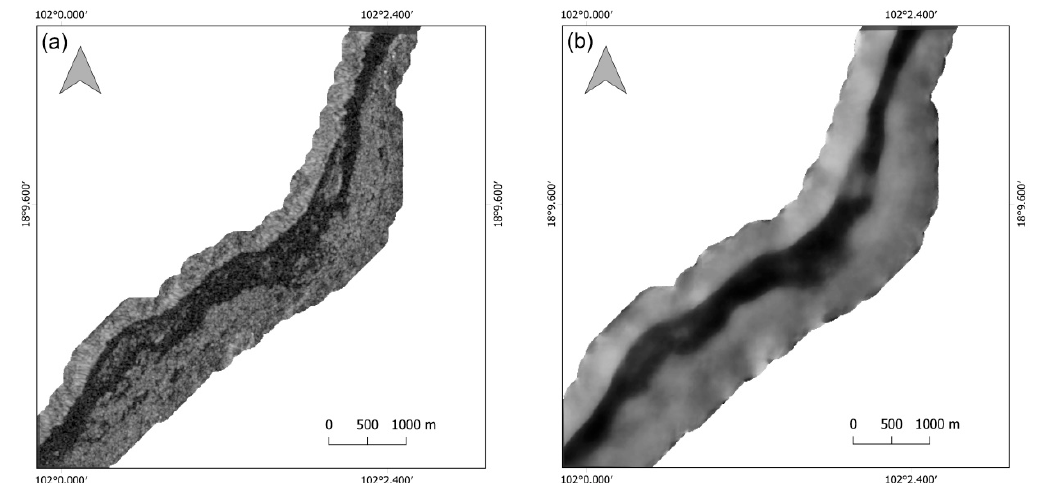
Figure 10. Sentinel-1 image ( a ) before and ( b ) after spatial filtering.